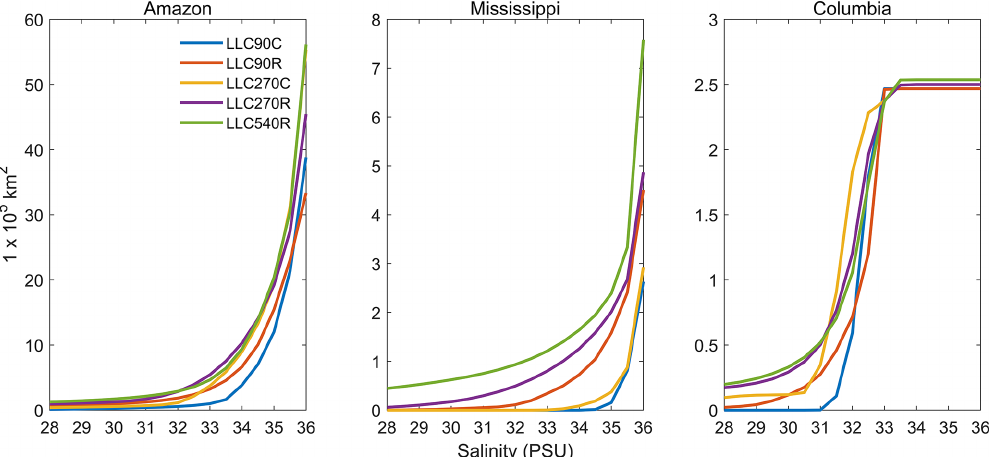
Figure 8. 2015–2017 averaged plume area at salinity threshold S A from 28 to 36 for the Amazon, Mississippi, and Columbia River